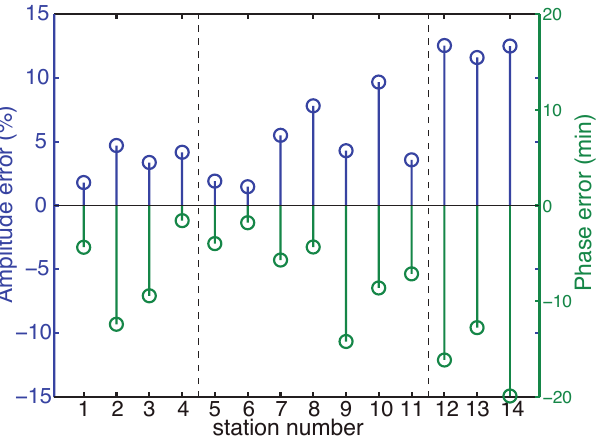
Figure 5. Amplitude error (in percentage of the measured ampli- tude) and phase error (in minutes) of the simulated M2 tidal con- stituent when compared with the measurements. The dashed lines divide North Sea, WDWS and EDWS stations. Figure 6. Scatter plot of observed vs. simulated SSH (in metres)